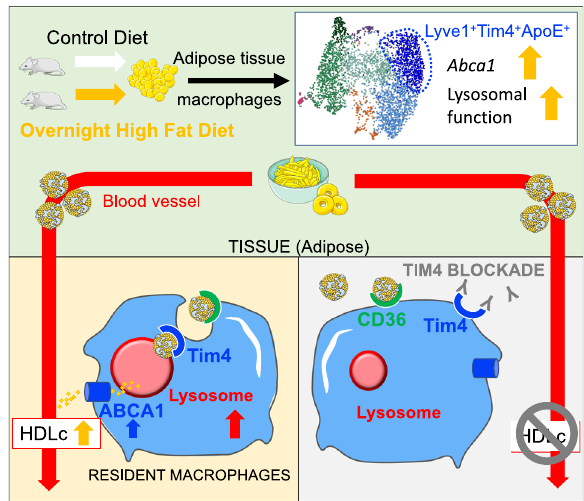
Fig. 8 Tim4 links regulation of post-prandial cholesterol transport and ABCA1 + ATM metabolism. A high-fat diet (HFD) meal leads to increase in Abca1 expression and lysosomal function in Tim4 + resident adipose tissue macrophages (ATMs). CD36 mediates lipoprotein particle uptake by ATMs, and Tim4 is required for lysosomal activation following uptake. Blocking Tim4 prevents lysosomal activation in ATMs and inhibits post- prandial HDLc